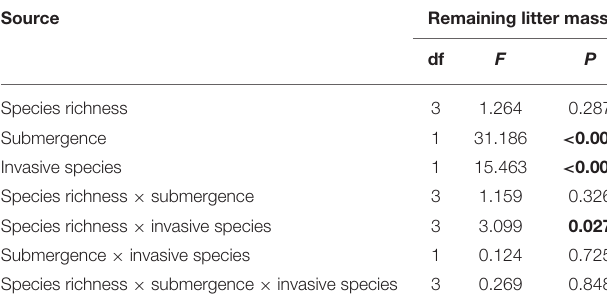
TABLE 5 | Three-way ANOVA results for litter mass remaining rates on different species richness in the riparian zone of the Three Gorges Reservoir in China.